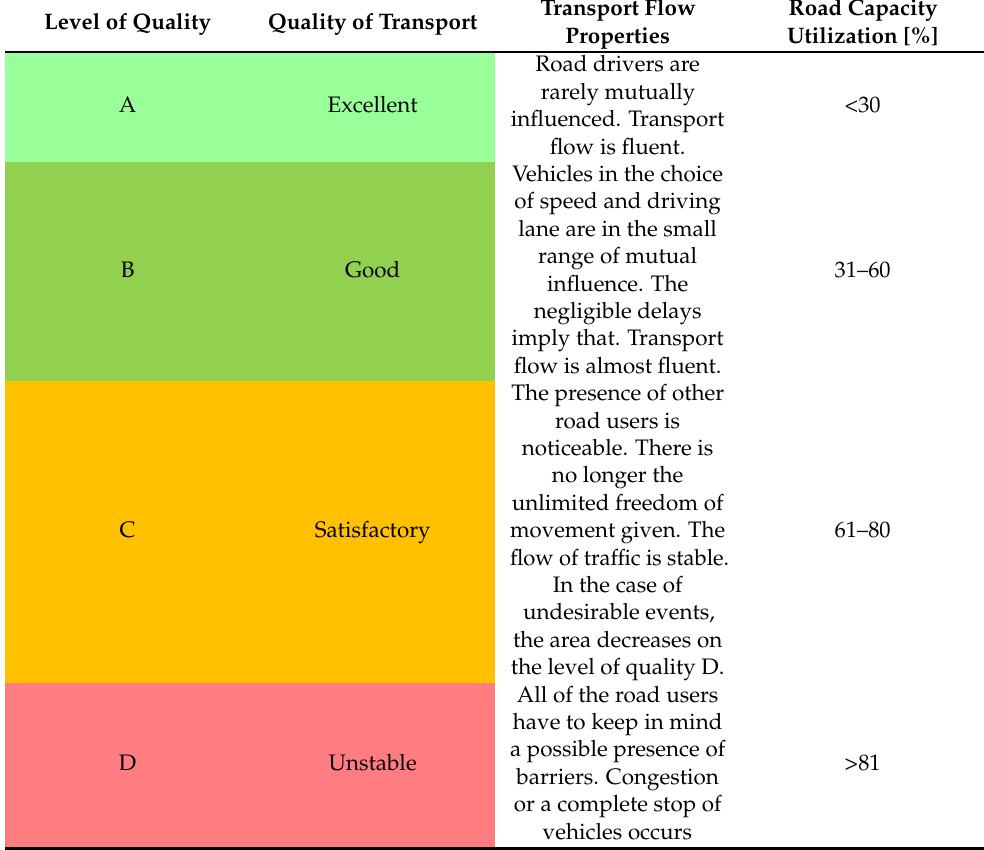
Table 10. Classification of local roads according to capacity load (source elaborated by authors). Level of